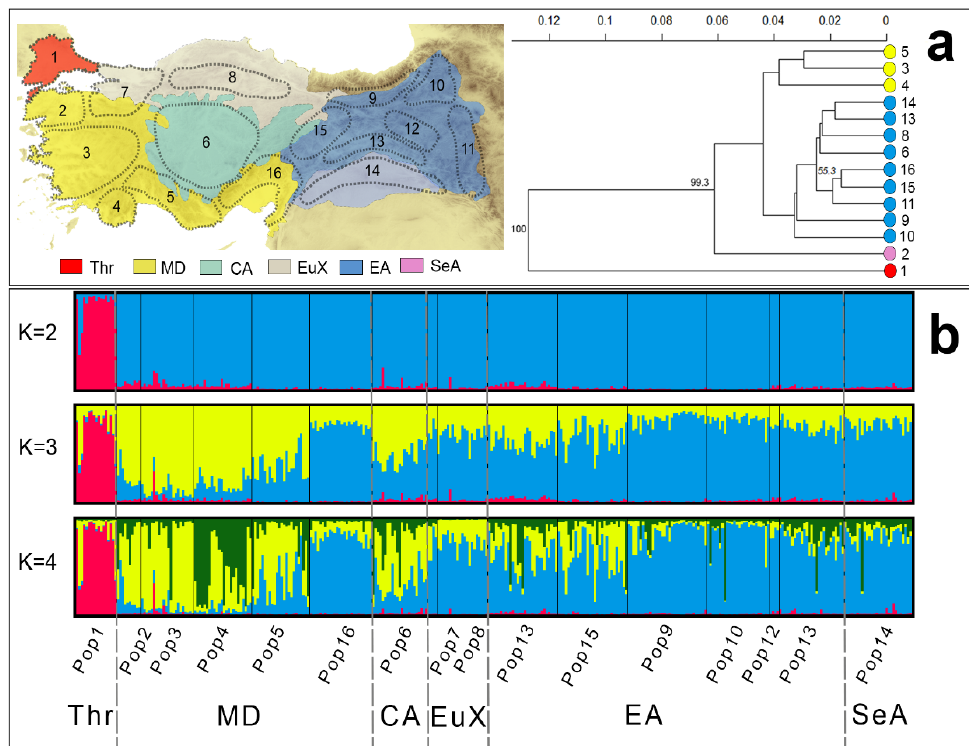
Figure 5. Genetic structure of A. chukar in Türkiye based on microsatellite analyses. The map shows the sampling areas and genetic clusters. ( a ) Nei distance dendrogram. ( b ) Structure analysis results for A. chukar genotypes computed by structure with K = 4. Each individual is represented as a vertical bar partitioned in K segments, whose length represents the assignment probability to the K = 4 cluster. Specimens are grouped according to their populations of origin.